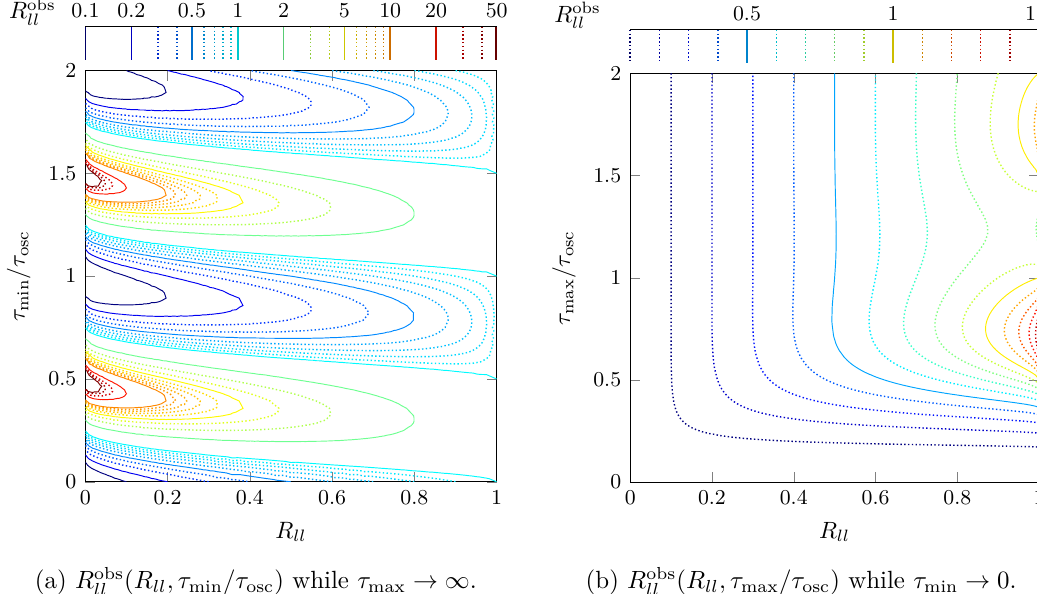
Figure 5 . Impact of the finite detector size on the measurement of R ll . The plots show the observable R obs as a function of τ/τ osc and the theoretical R ll , calculated by taking the limits ( 3 . 8 ) ll simultaneously. In panel (a) τ min is variable and τ max τ min → 0 . Note that only in the region where the contours are vertical that R obs is not bound to be smaller or equal to one and even has poles in panel ll